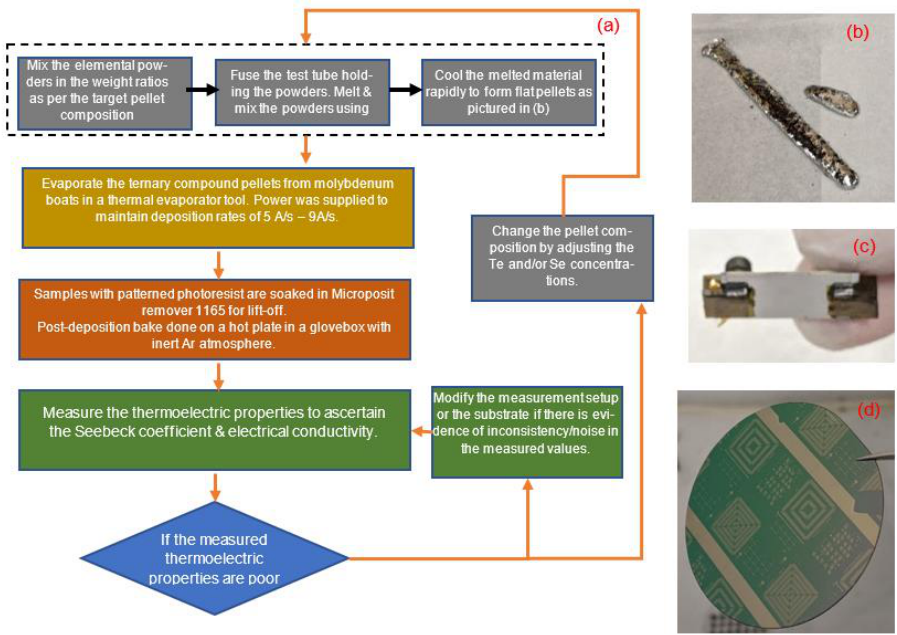
Figure 2. ( a ) The flowchart details the steps to achieve device-quality thin films. The composition of the ternary compound pellets and the post-deposition anneal were the key parameters explored for optimization. ( b ) Pellets evaporated to form thermoelectric thin films. ( c ) A 17 mm × 8 mm thin film sample mounted for measurement on the LSR tool. ( d ) Thermoelectric thin films patterned via lift- off process.